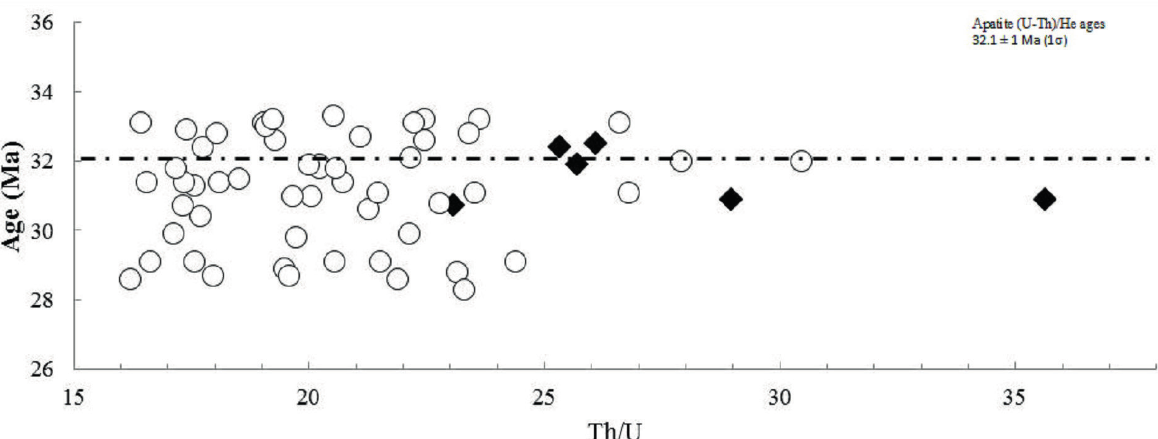
Figure 5 - Plot of apatite (U-Th)/He ages versus Th/U. Durango fluorapatite. Black diamonds represent SUERC (EK) Durango; White circles are UNESP Rio Claro DUR UNESP (RC) Durango. Dashed line is Durango fluorapatite He ages of (House et al. 2000) (32.1 ± 1.7 Ma (2 σ ,